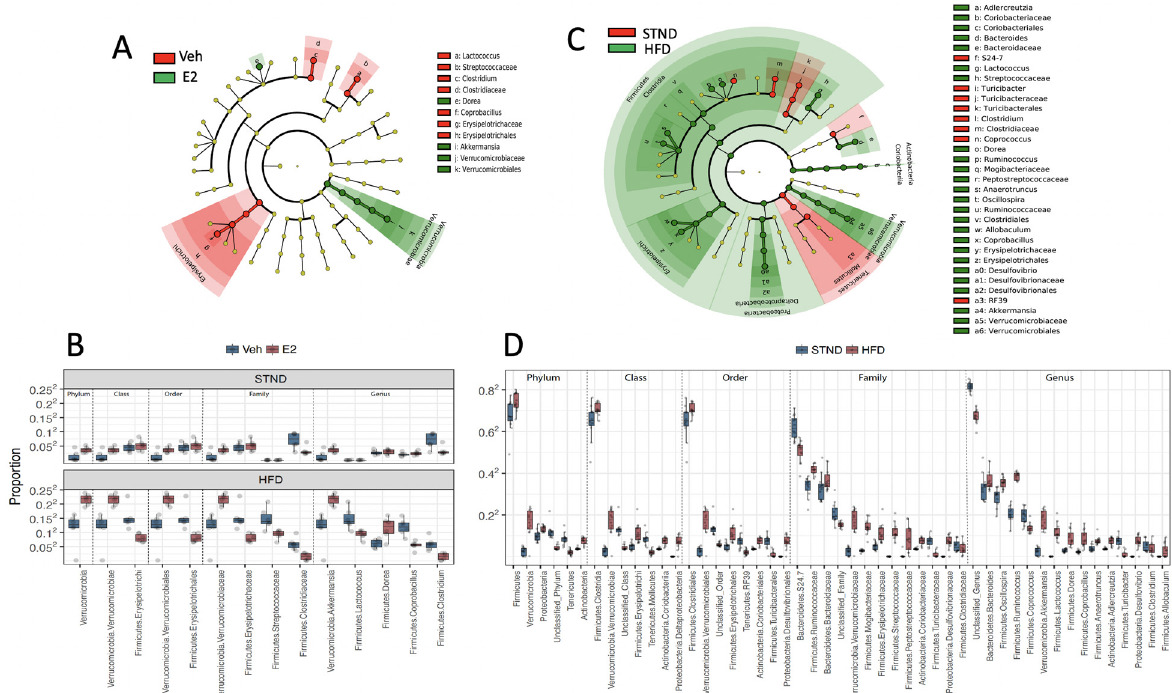
Figure 8. Estradiol and HFD alter gut microbiota taxa diversity in female mice. Cladogram ( A ) and relative proportions ( B ) of taxa associated with E2 or Veh, subgrouped as phylum, class, order, family and genus. Samples during STND (D0 and D8) and HFD feeding (D23 and D45) were analyzed. Cladogram ( C ) and relative proportions ( D ) of taxa associated with STND (D0 and D8) or HFD (D23 and D45). The innermost nodes in the cladogram represent phyla and the connecting outer nodes represent lower taxa within the phylum. q-value < 0.05 (generalized mixed effects model) considered significant. n = 24/group for ( A , C ), and n = 12/group for ( B , D ).